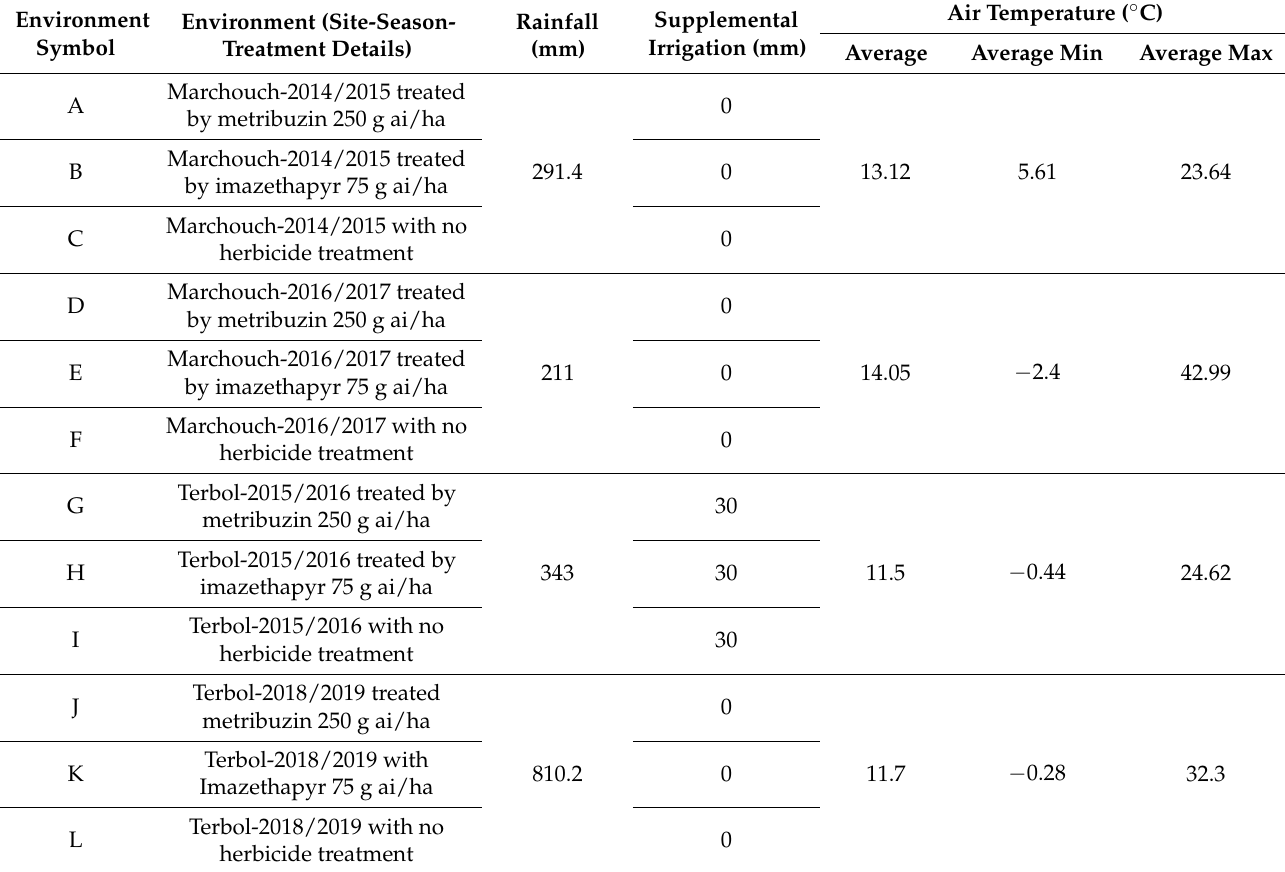
Table 7. Details of different environments where the faba bean accessions were